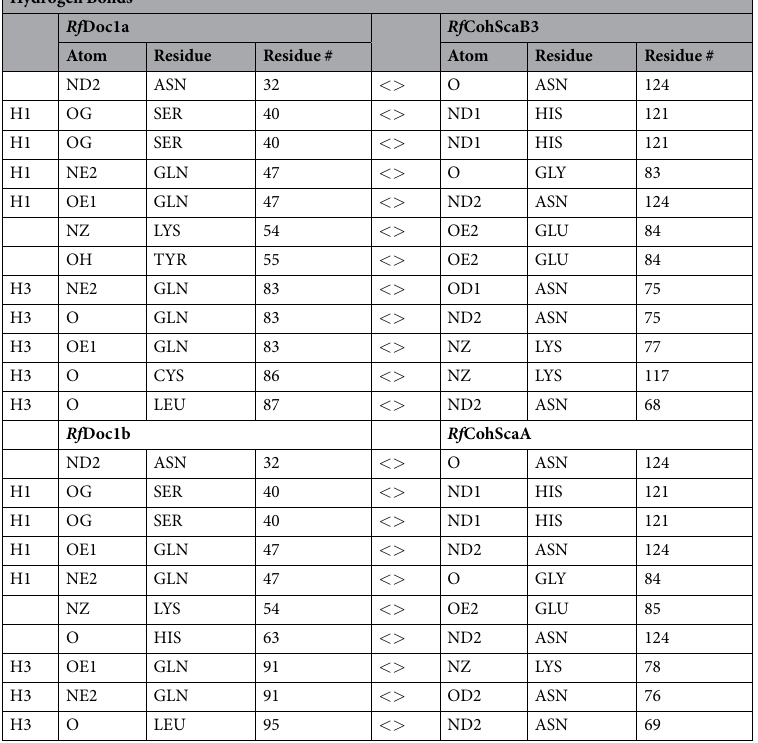
and the aliphatic region of Asn-124 side-chain. The hydrogen bond network established by α -helix 1 is dominated by the interaction of Ser-40, Gln-47 and Lys-54 with His-121/His-121, Asn-124/Asn-124 and Glu-84/Glu-85 of Rf CohScaB3/ Rf CohScaA, respectively. The two Docs are less conserved at the C-terminus of helix-1 and this generates differences in the interaction with the Coh. Thus, Rf Doc1a establishes an extra hydrogen bond between Tyr-55 O η (Phe-55 in Rf Doc1b) and O δ 2 of Rf CohScaB3 Glu-84. In addition, the longer loop connecting helices 1 and 2 in Rf Doc1b allows the carbonyl of His-63 to form a hydrogen bond with Asn-124 N δ 2 of Rf CohScaA. In α -helix-3 the contacts are dominated by the important salt bridges established between N ε 2 and O ε 1 of Gln-83/ Gln-91 of Rf Doc1a/ Rf Doc1b with O δ 1 of Asn-75/Asn-76 and N ζ of Lys-77/Lys-78 of Rf CohScaB3/ Rf CohScaA Cohs. In addition, the side chains of Leu-87/Leu-95 of Rf Doc1a/ Rf Doc1b occupy the hydrophobic pocket created by Gly-73/Gly-74, Ile-71/Ile-72 and the aliphatic portion of Met-66/Met-67 of Rf CohScaB3/ Rf CohScaA Cohs. The closer proximity of the two protein partners at the C-terminus of helix-3 in Rf CohScaB3-Doc1a protein complex allows the formation of two extra hydrogen bonds between Rf Doc1a and Rf CohScaB3 that are absent in Rf CohScaA-Doc1b. RfDoc1a and RfDoc1b present a single Coh-binding interface. The binding thermodynamics of Rf Doc1a and Rf Doc1b to Rf CohScaB3 and Rf CohScaA were assessed by isothermal titration calorimetry (ITC)